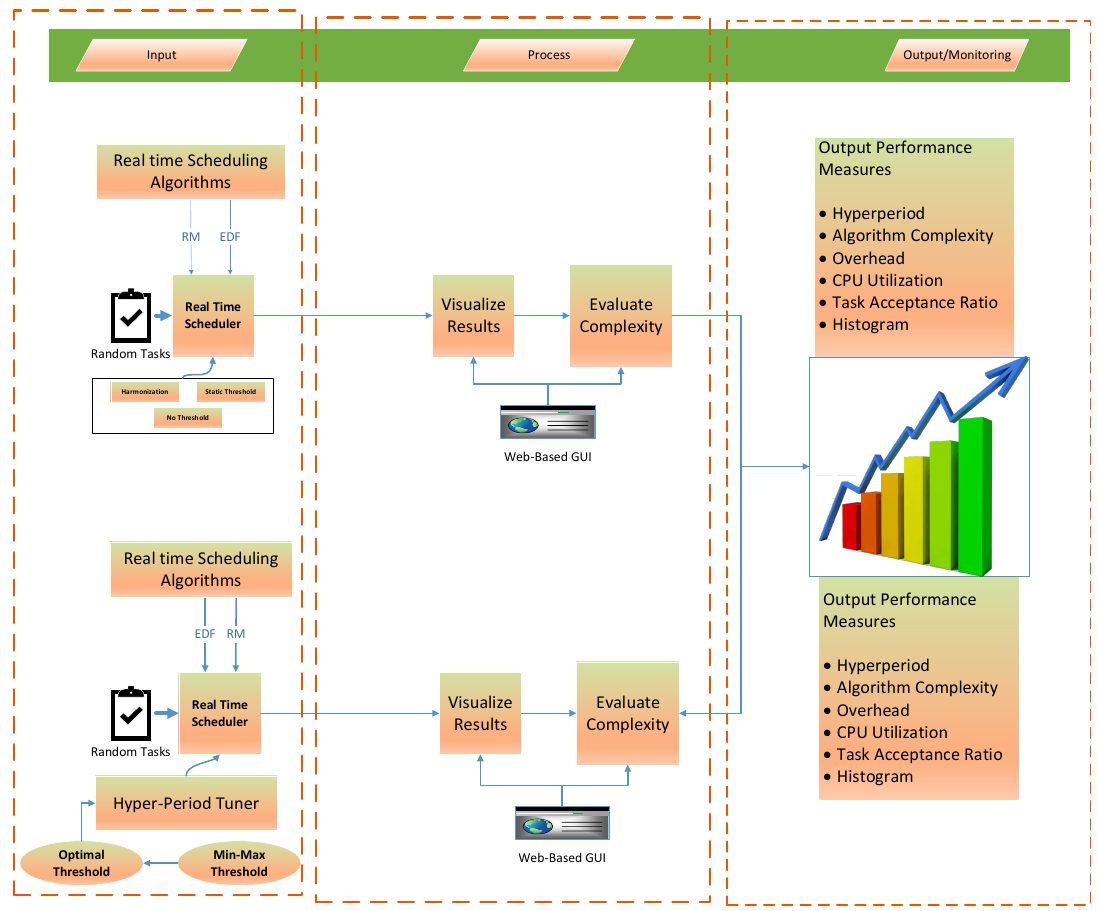
Figure 6. Flow of different processes in experimental